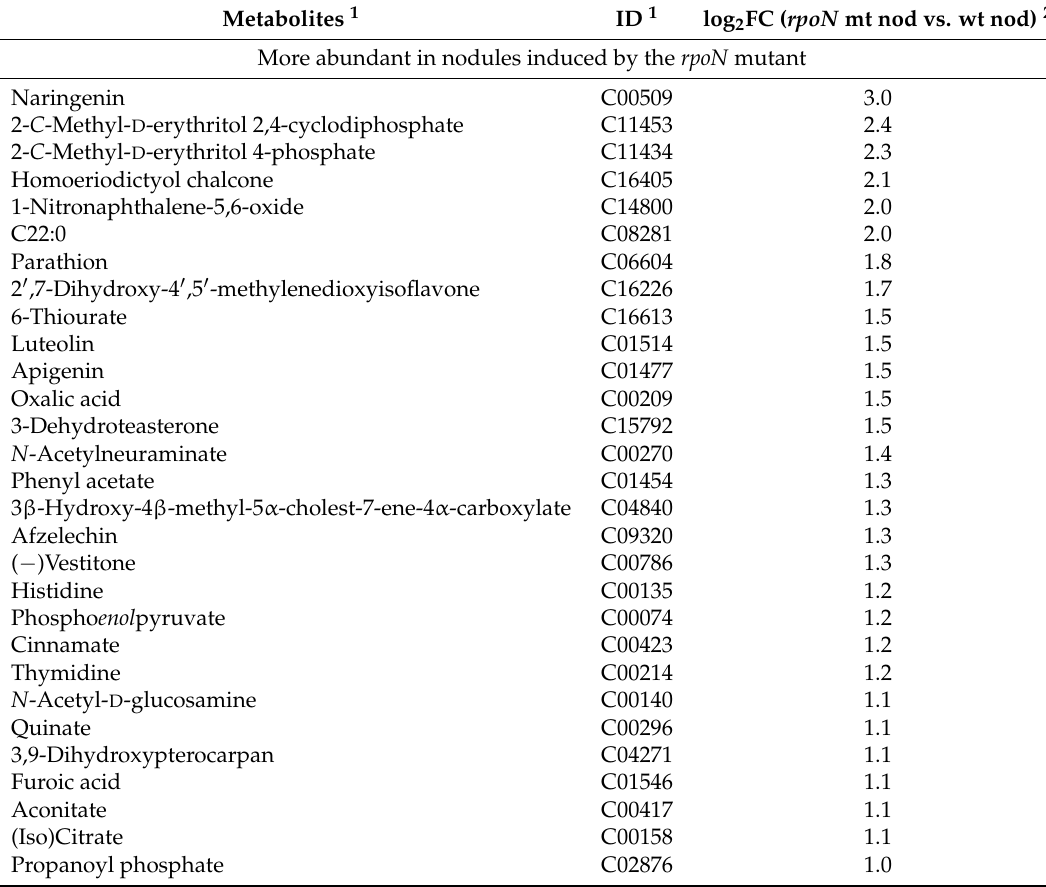
Table 2. List of 147 metabolites that significantly differentially accumulated in P. vulgaris nodules, induced by a P. phymatum wild-type (wt nod) and by an rpoN mutant strain ( rpoN mt